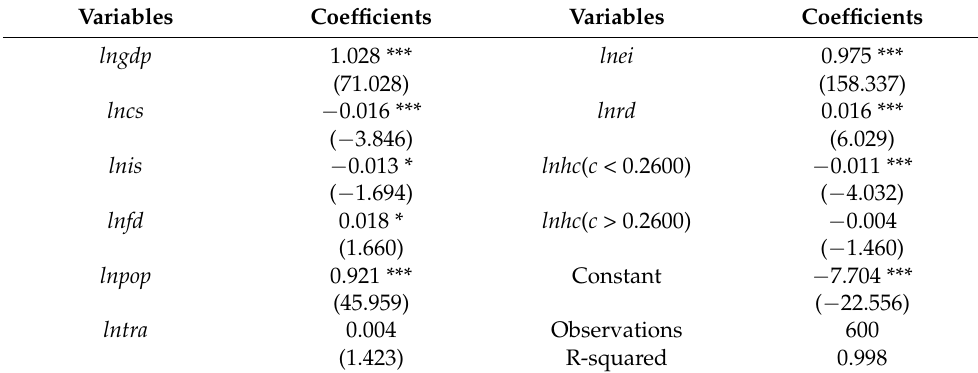
Table 5. Panel threshold regression results.